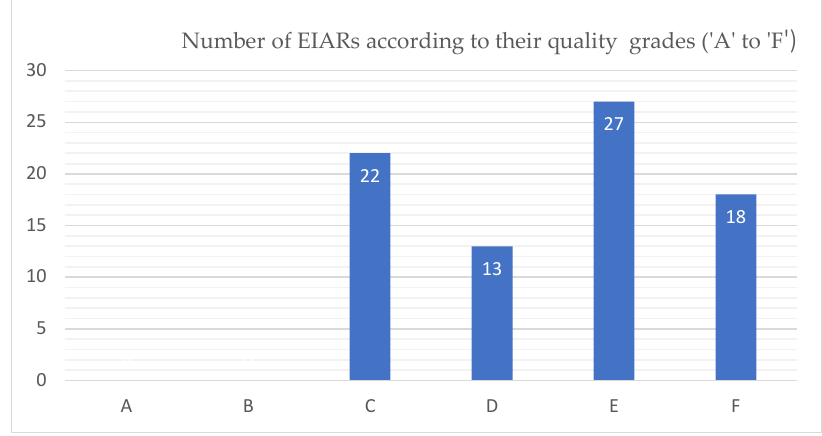
Figure 2. The numbers of EIARs according to the quality grades allocated to them.